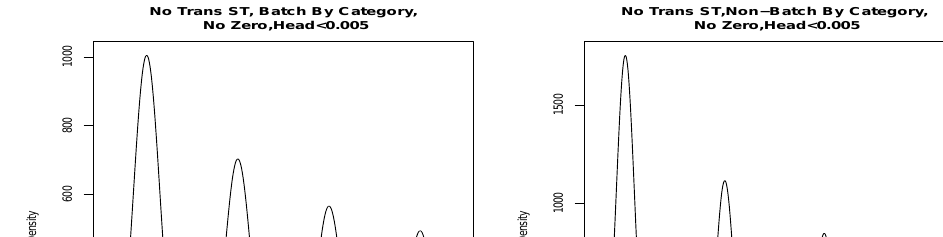
Figure 23. Histogram batch by category—milliseconds.